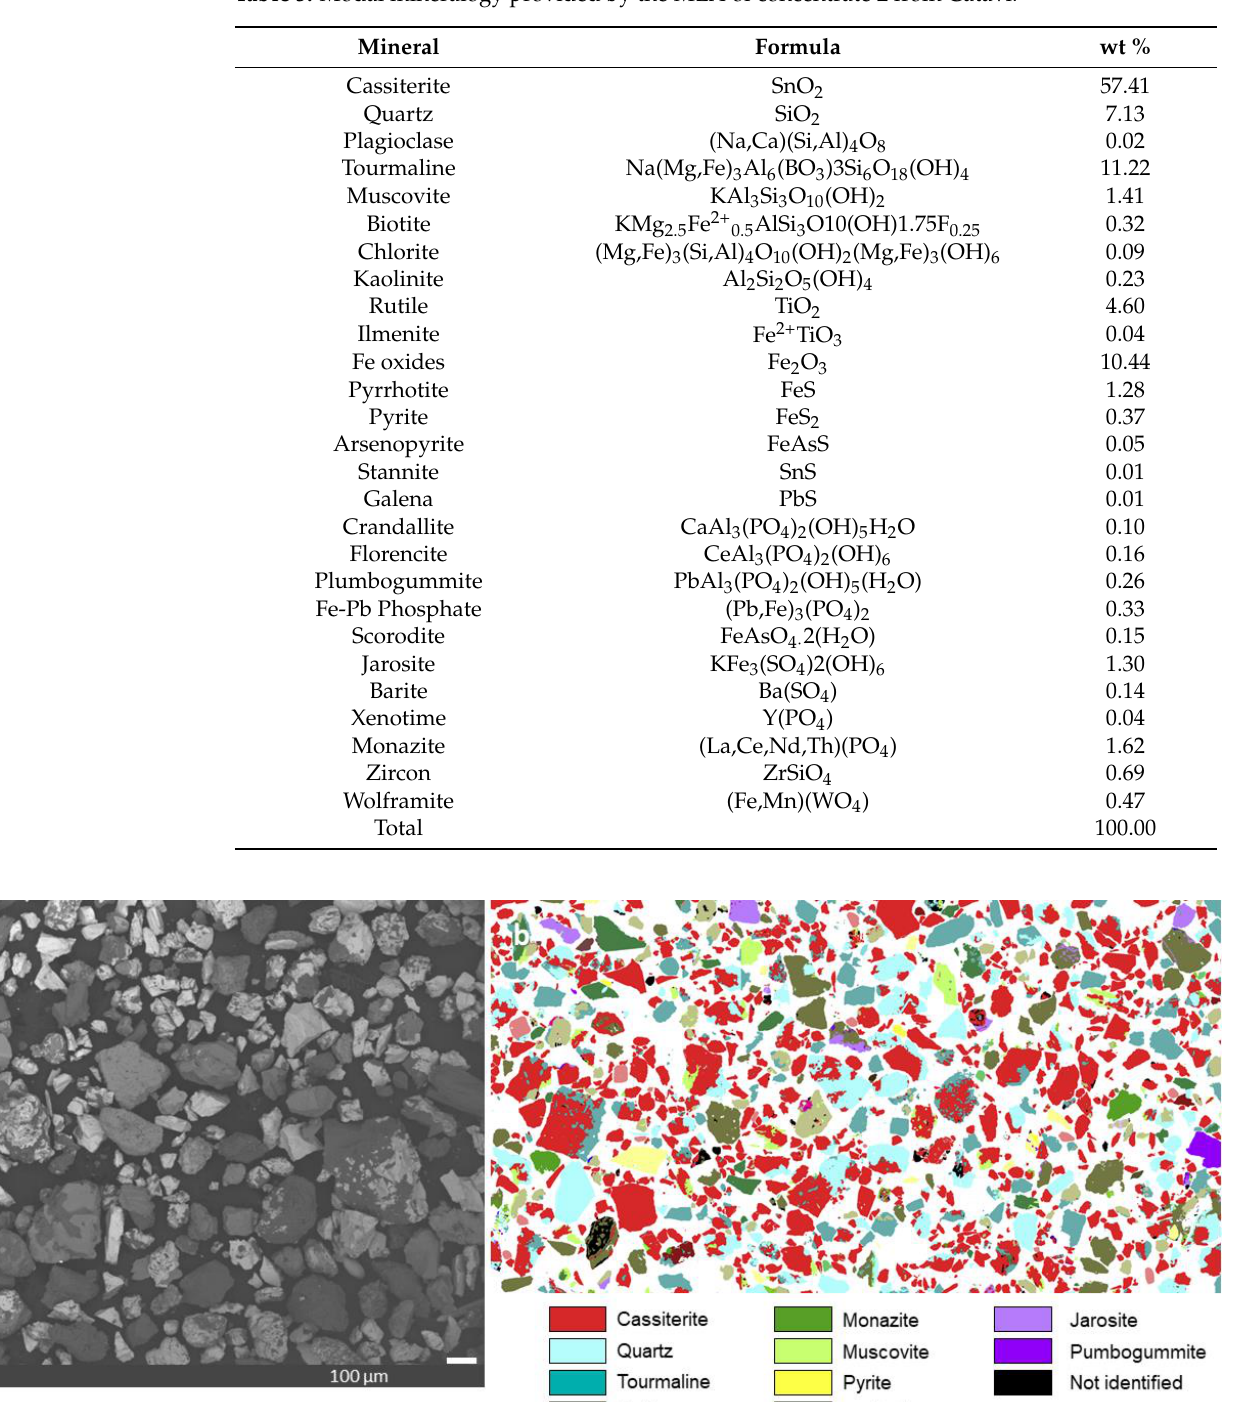
Table 3. Modal mineralogy provided by the MLA of concentrate 2 from Catavi.